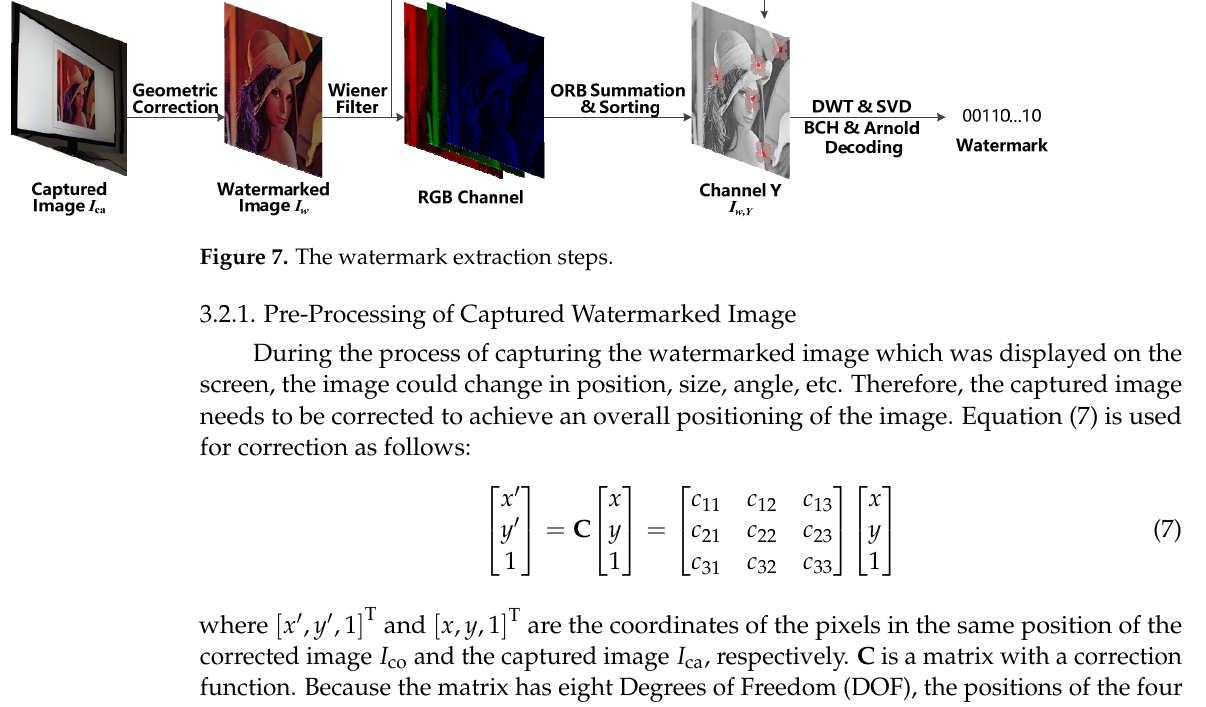
10 of 23 Figure 6. The embedded template of the watermark: ( a ) Watermark bit “1”; ( b ) Watermark bit “0”. After modifying the coefficients of the U matrix, we perform inverse SVD and inverse DWT processes, respectively, to convert the image back to the spatial domain. After the embedding process of a feature region is completed, the remaining feature regions are processed in the same way. Finally, the Y channel component